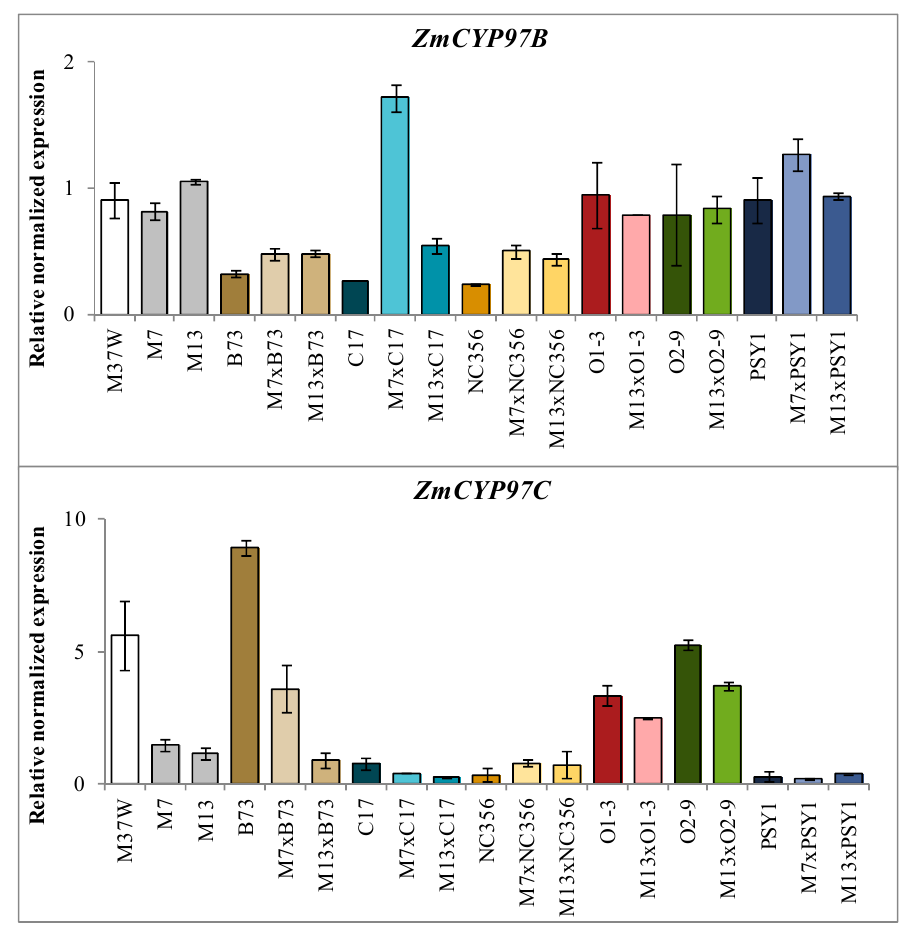
Figure 5. Expression of the endogenous hydroxylase genes ZmBCH1 , ZmBCH2 , ZmCYP97A , ZmCYP97B, and ZmCYP97C in 30 DAP maize endosperm, normalized against actin and relative to the expression levels in wild-type M37W maize and presented as the mean of three replicates ± SE. Abbreviations: ZmBCH1 , carotenoid β -hydroxylase 1 ; ZmBCH2 , carotenoid β -hydroxylase 2 ; ZmCYP97A/B , carotenoid β -hydroxylase ; ZmCYP97C, carotenoid ε -hydroxylase